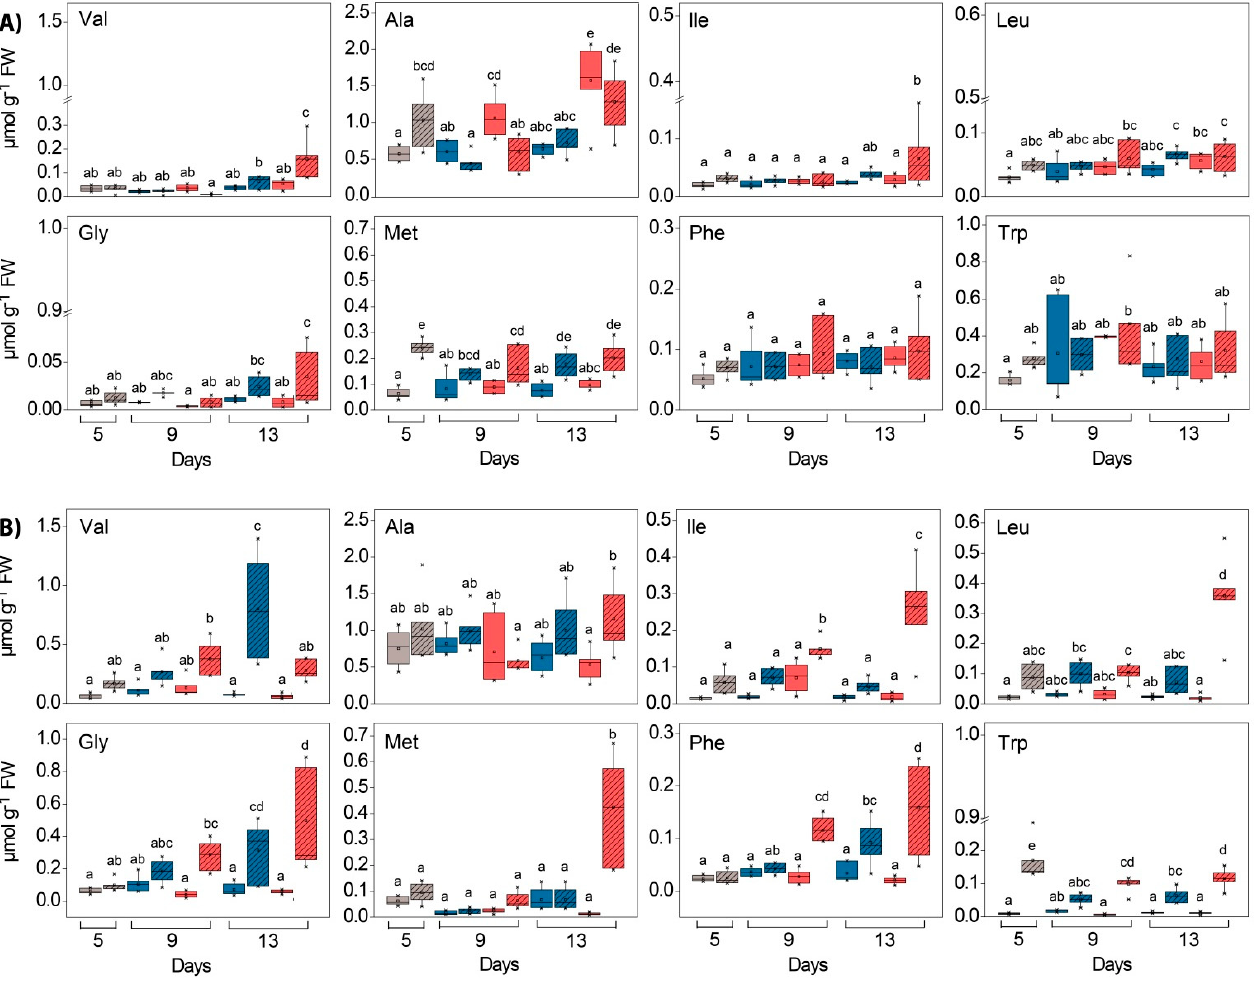
Figure 13. Content of nonpolar free amino acids (Val, Ala, Iso, Leu, Gly, Met, Phe, Trp) in GL (solid boxes) and WL (striped boxes) of P. zonale plants prior to (5 d, grey) and after four (9 d) and eight days (13 d) of exposure to high light (HL, 800 µmol m –2 s –1 , red) compared with those exposed to low light (LL, 180 µmol m –2 s –1 , blue) under ( A ) optimal (25 °C, HL ) and ( B ) lower (18 °C, Cold + HL ) temperatures. Values are shown in µmol g –1 FW ± SE, n = 6–8. Different letters indicate statistically significant differences between different PAR intensities, time points, and leaf tissues ( p < 0.05) according to Tukey’s post hoc test.